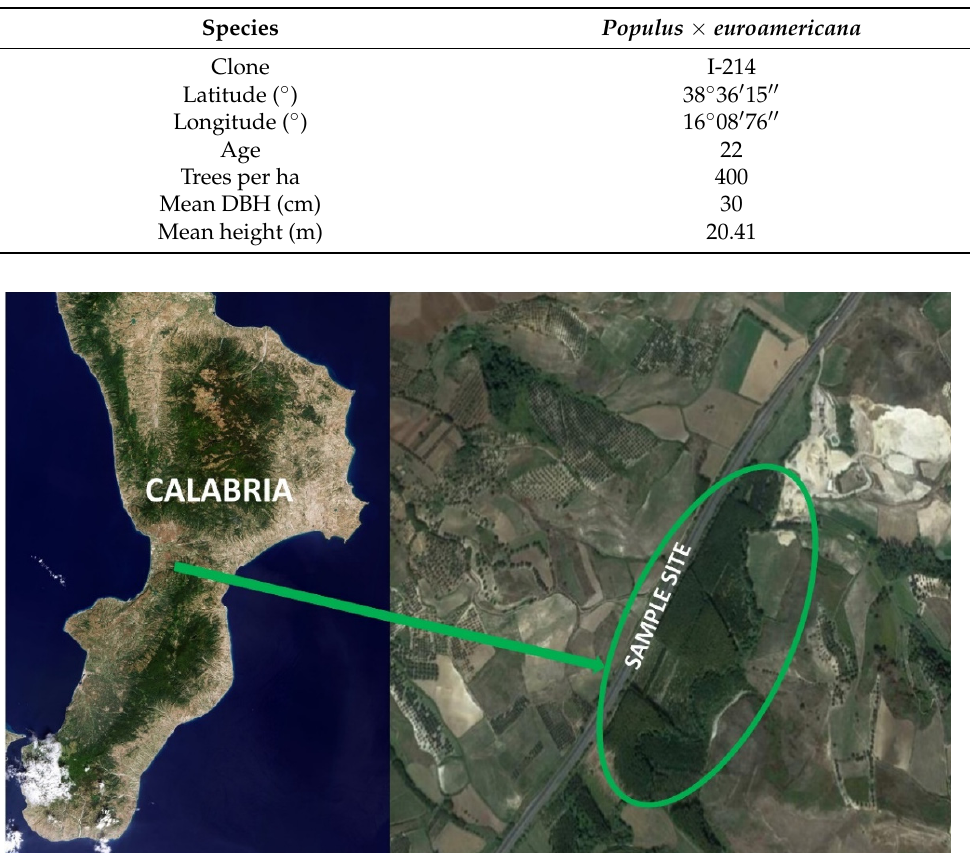
Figure 1. Site map located in Calabria region (southern Italy).